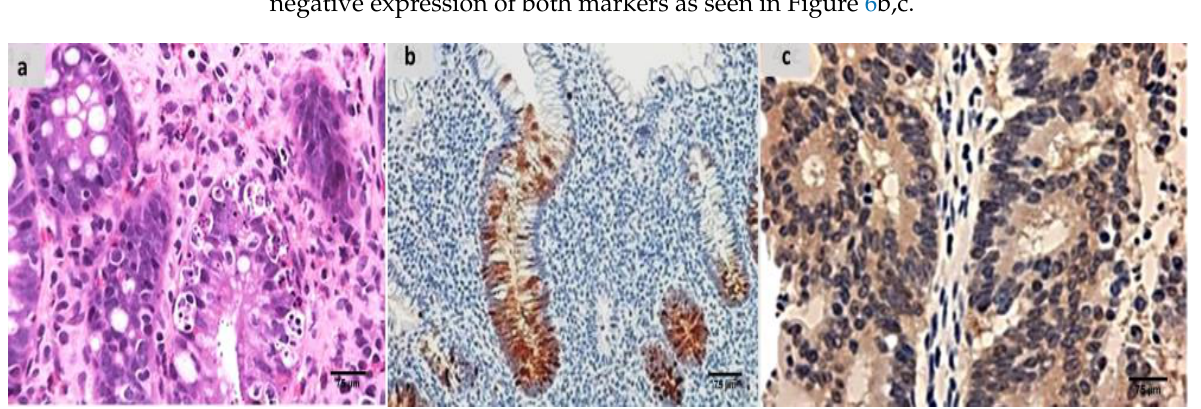
Figure 4. ( a ) β -glucan-treated group showing decreased activity into Geboes score 3.1 in the form of cryptitis and neutrophils seen in some of the epithelium (H&E × 200). ( b ) The same case showed less number of positive mucosal cells for calprotectin expression ( × 200), ( c ) also showed weak positive expression of S100A12 ( × 200).